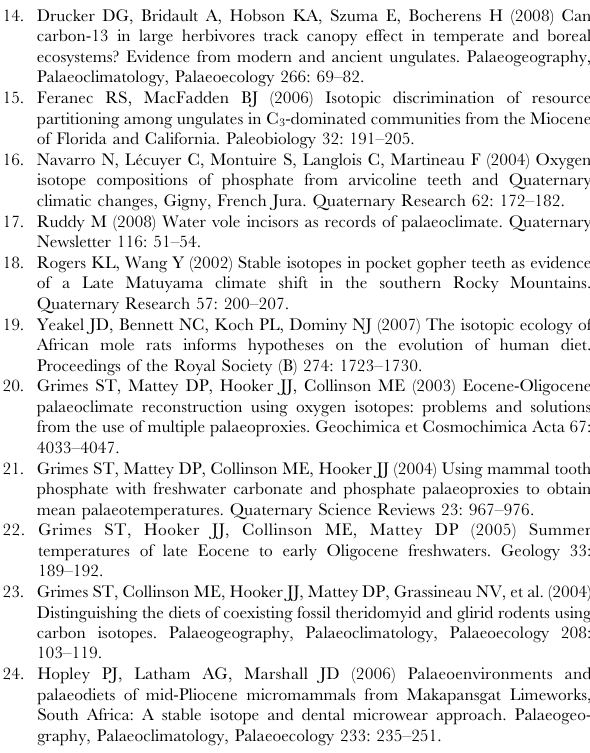
Table S1 Detailed summary of analytical results